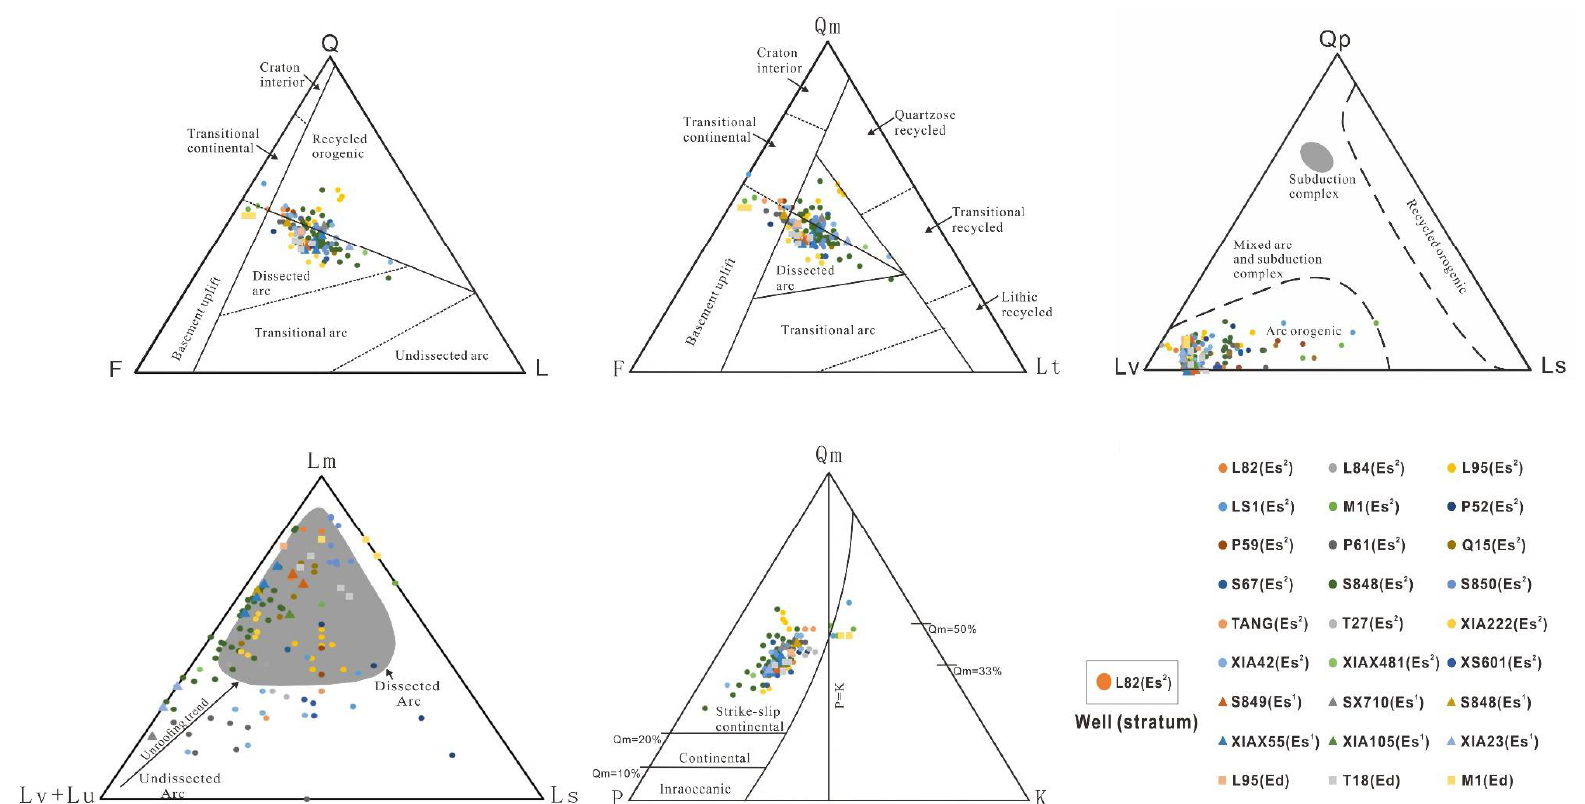
Figure 5. Rock constituent Dickinson diagrams. Q = quartz; F = feldspars; L = unstable lithic grain; Qm = monocrystalline quartz (>0.0625 mm); Lt = total lithic fragments (Lt = L + Qp); Qp = polycrystalline quartz (including chert); Lv = volcanic, metavolcanics, and mafic metaigneous lithic grains; Ls = sedimentary lithic grain fragments; Lu = ultramafic lithic grains (serpentinite, serpentine schist); P = plagioclase grains; K = potassium feldspar grains. The tectonic setting of the provenance area is an island arc orogenic belt.